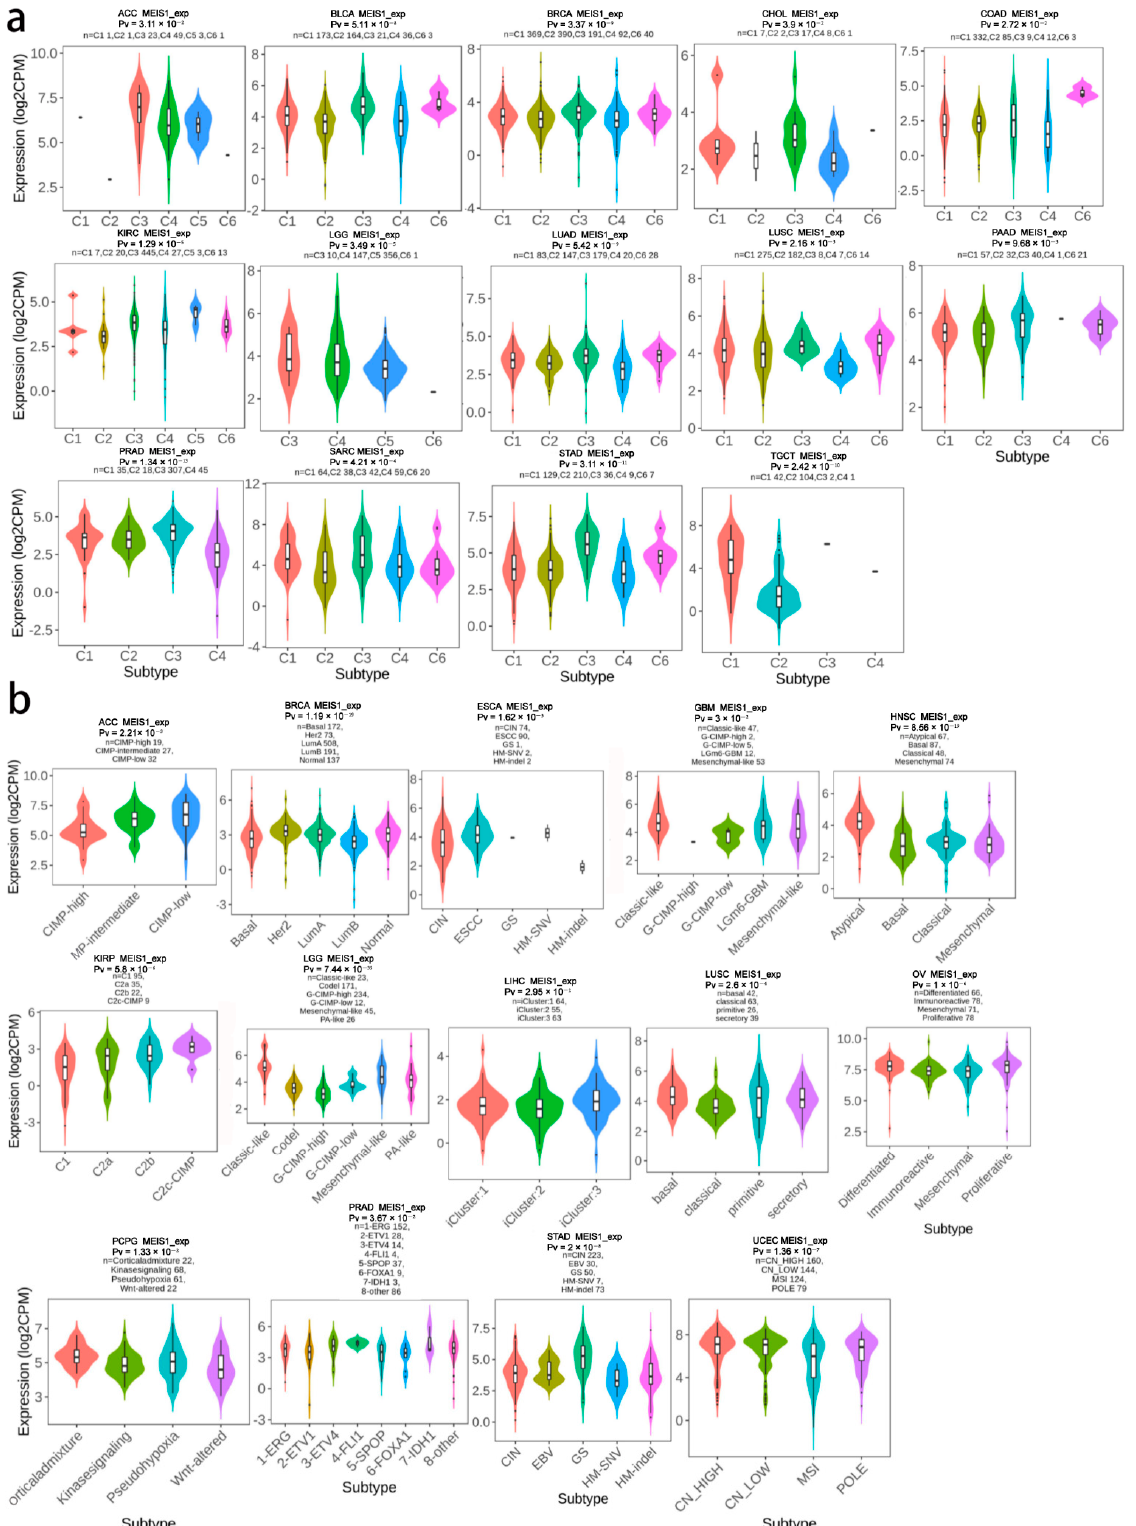
Figure 5. MEIS1 expression in immune and molecular subtypes of cancers ( a ) The relationship between MEIS1 expression and immune subtypes of cancers. ( b ) The relationship between MEIS1 expression and molecular subtypes of